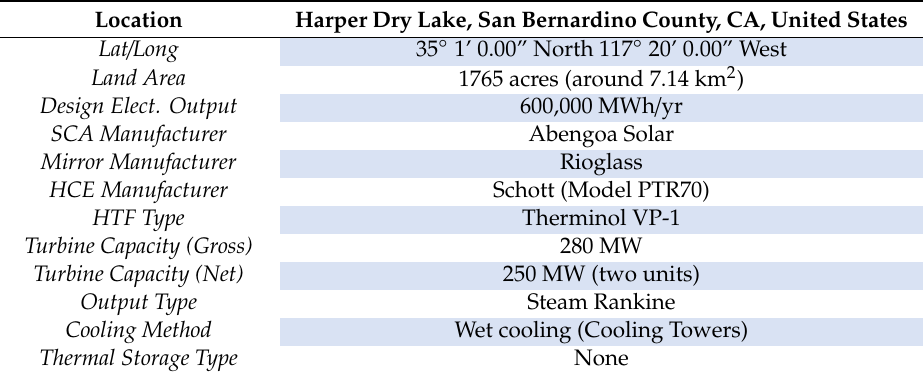
Table 2. Mojave Project specifications [38].